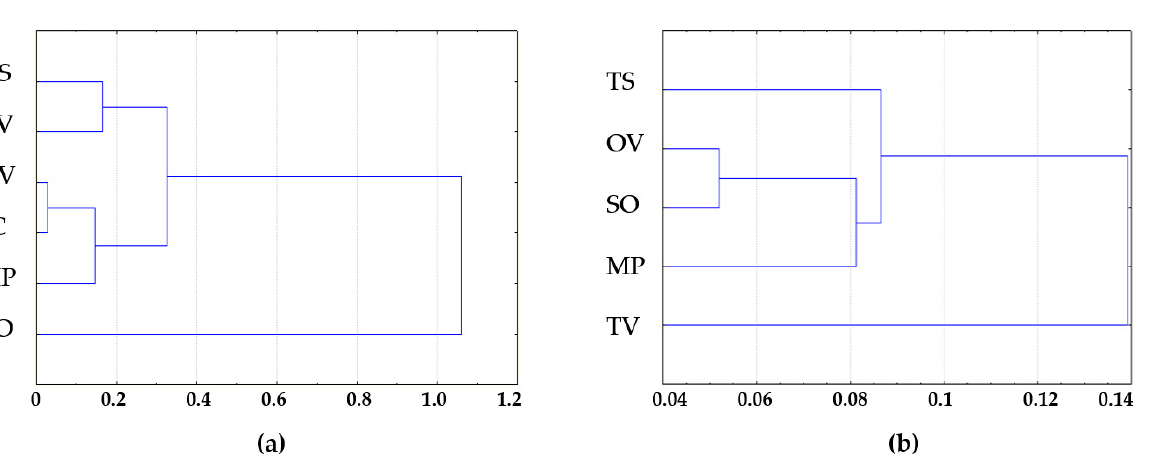
Table 2. Diversity indices of microbial communities in Lamiaceae L. medicinal plants rhizosphere.